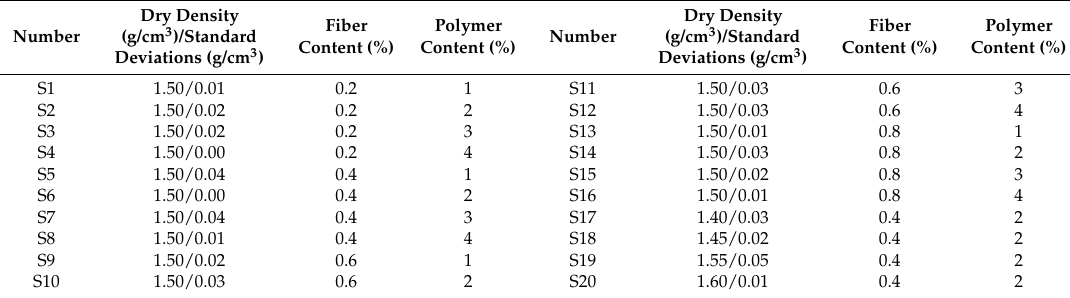
Table 3. The relevant parameters of specimens.